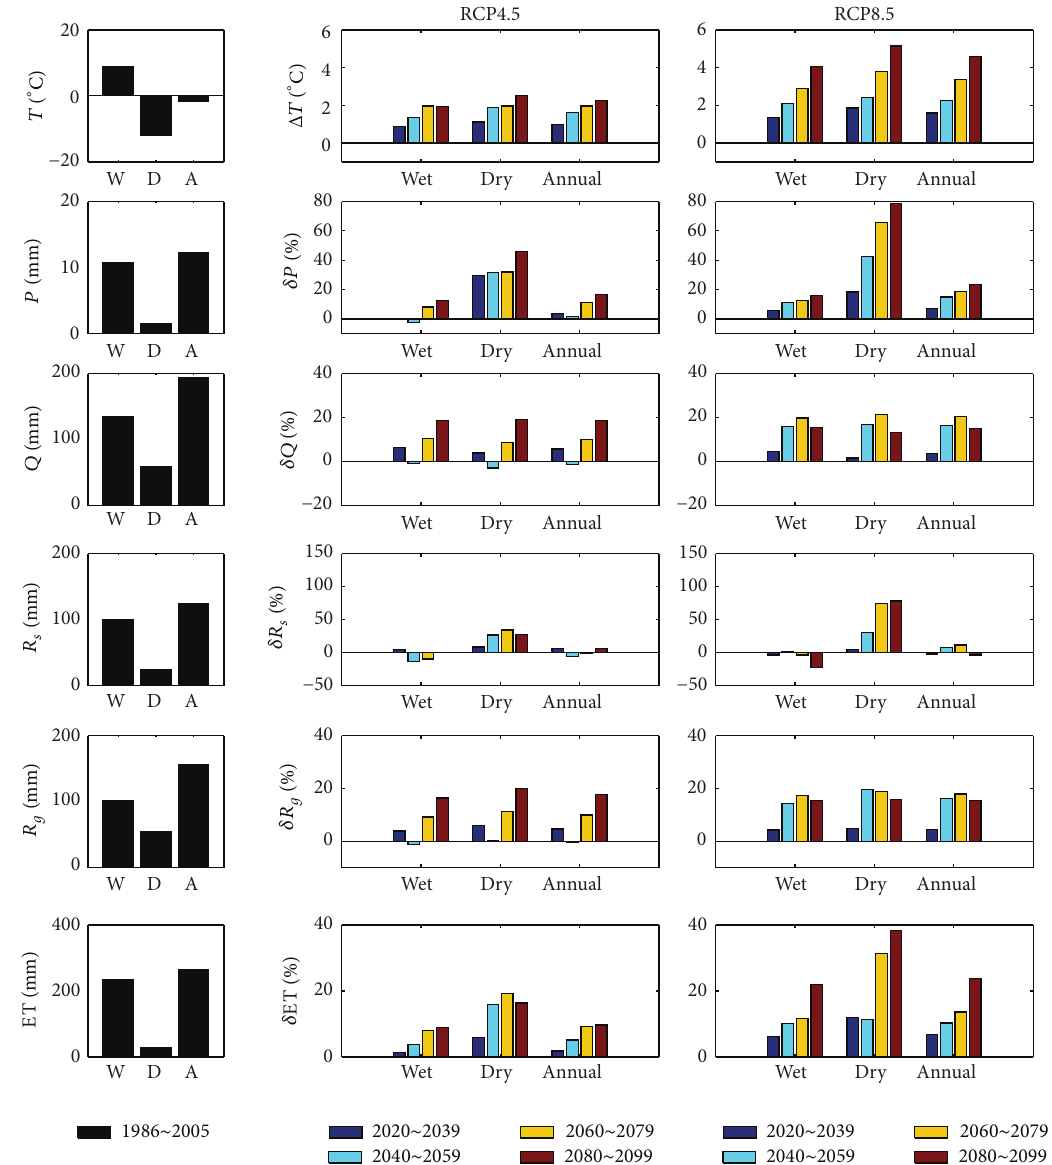
Figure 3: Summary of future climate inputs ( 𝑃 and 𝑇 ) and simulated hydrologic components ( 𝑄 , 𝑅 𝑠 , 𝑅 𝑔 , and ET) under RCP4.5 and RCP8.5, compared to their values in the control period (1986 ∼ 2005). All these hydrometeorologic factors are presented in terms of wet season, dry season, and annual